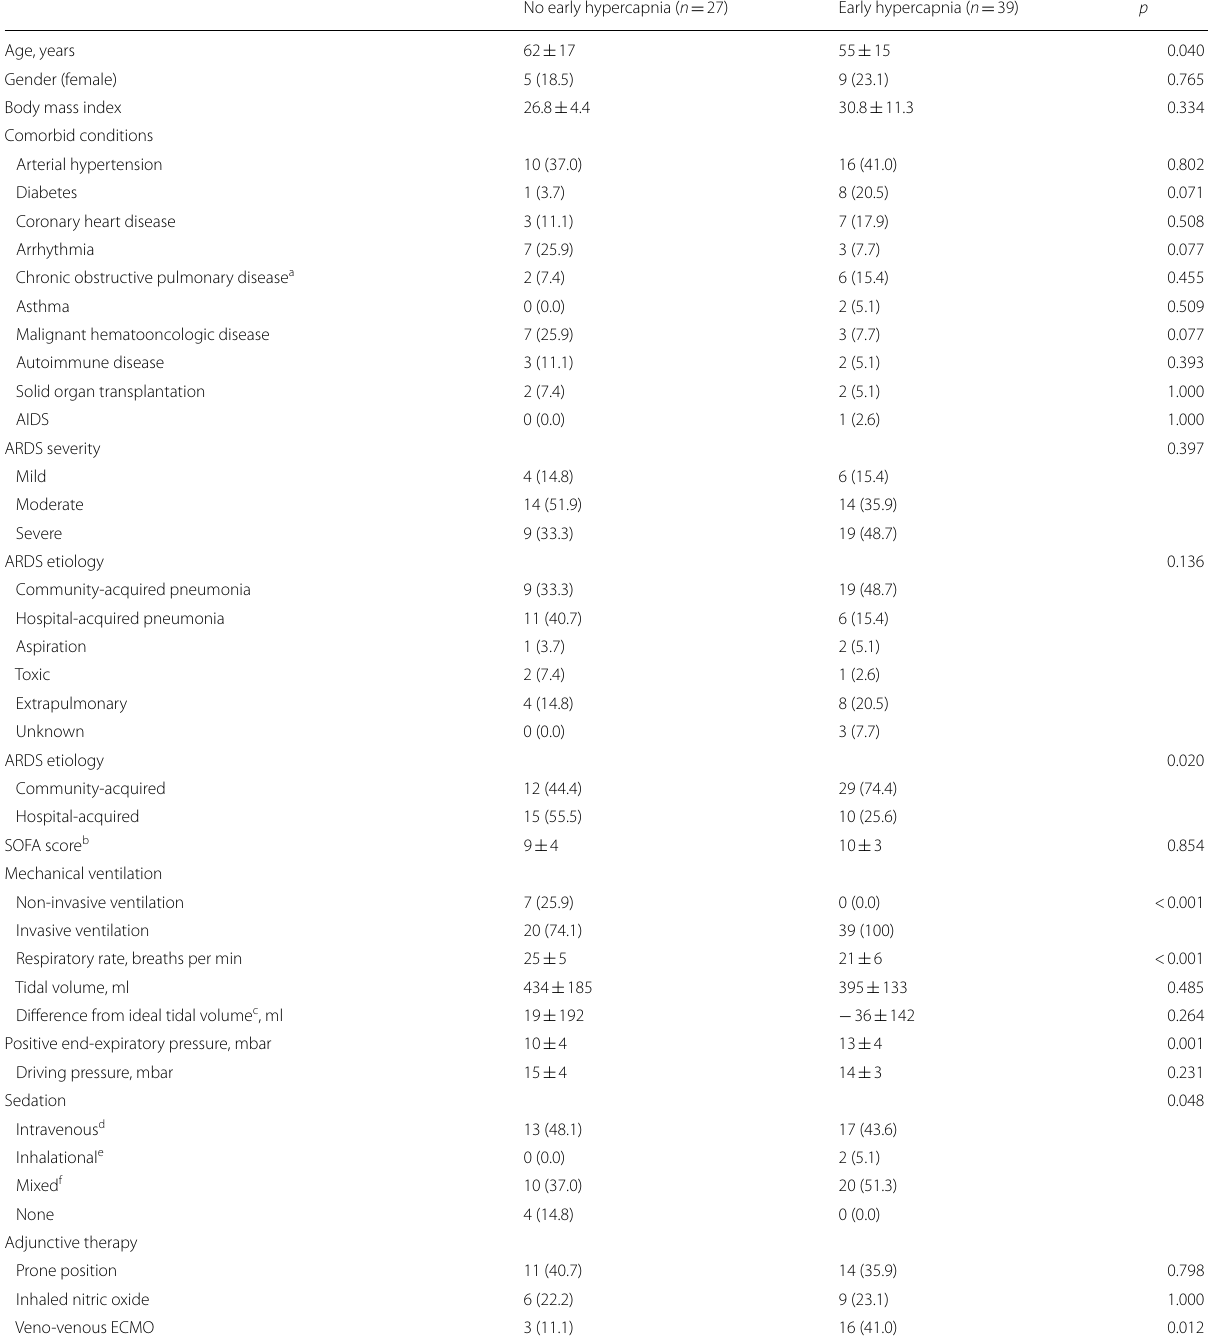
Table 1 Baseline demographic and clinical characteristics and details on the management of acute respiratory distress syndrome